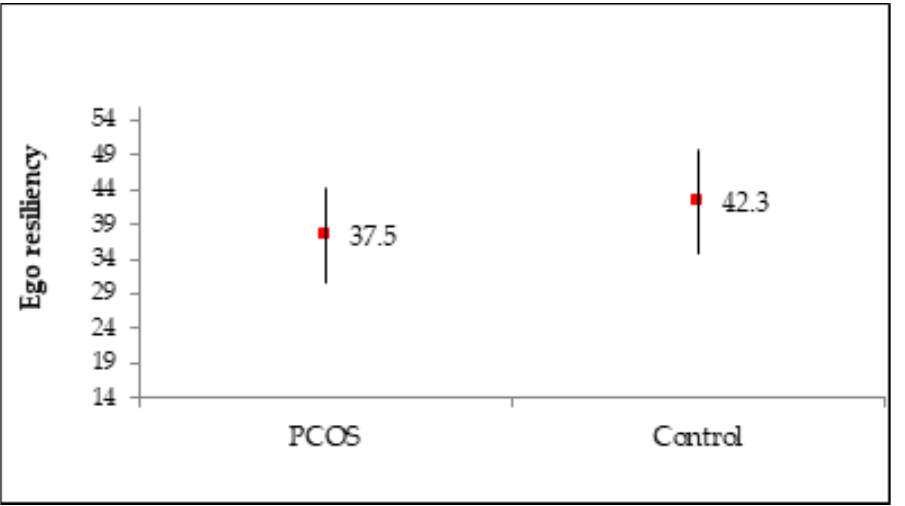
Figure 1. Ego-resiliency in the PCOS group and control group. Results are presented as mean ± stan-